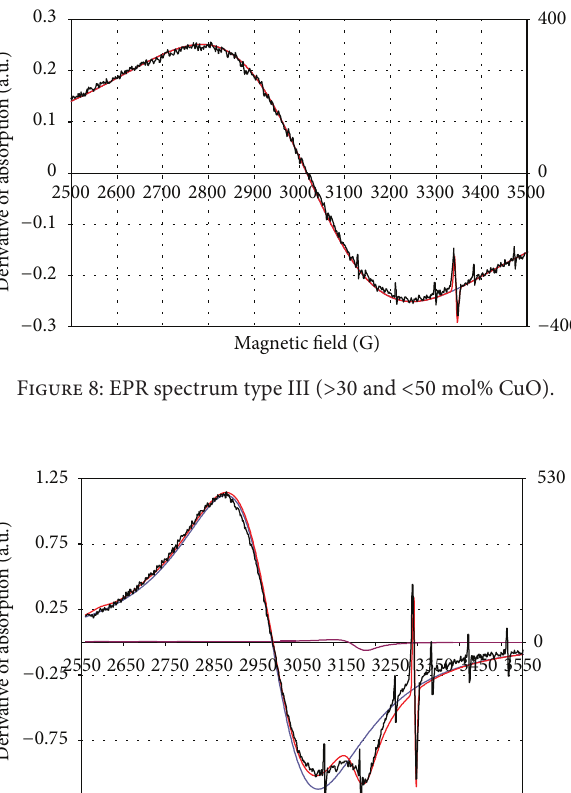
Figure 7: EPR spectrum type II (10–30mol% CuO). Black spectrum experimental, red spectrum calculated.